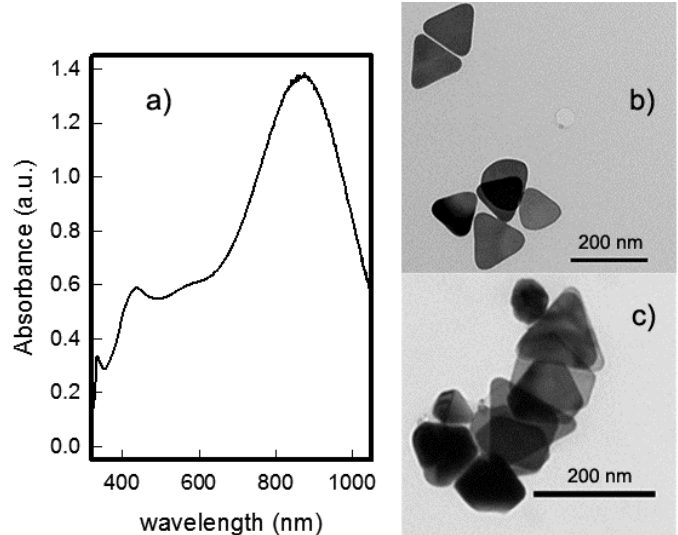
Figure 1 . ( a ) UV–vis spectra of colloidal suspension of silver nanoplates obtained with the standard preparation; ( b , c ) Transmission electron microscope (TEM) images of silver nanoplates obtained with the standard preparation.